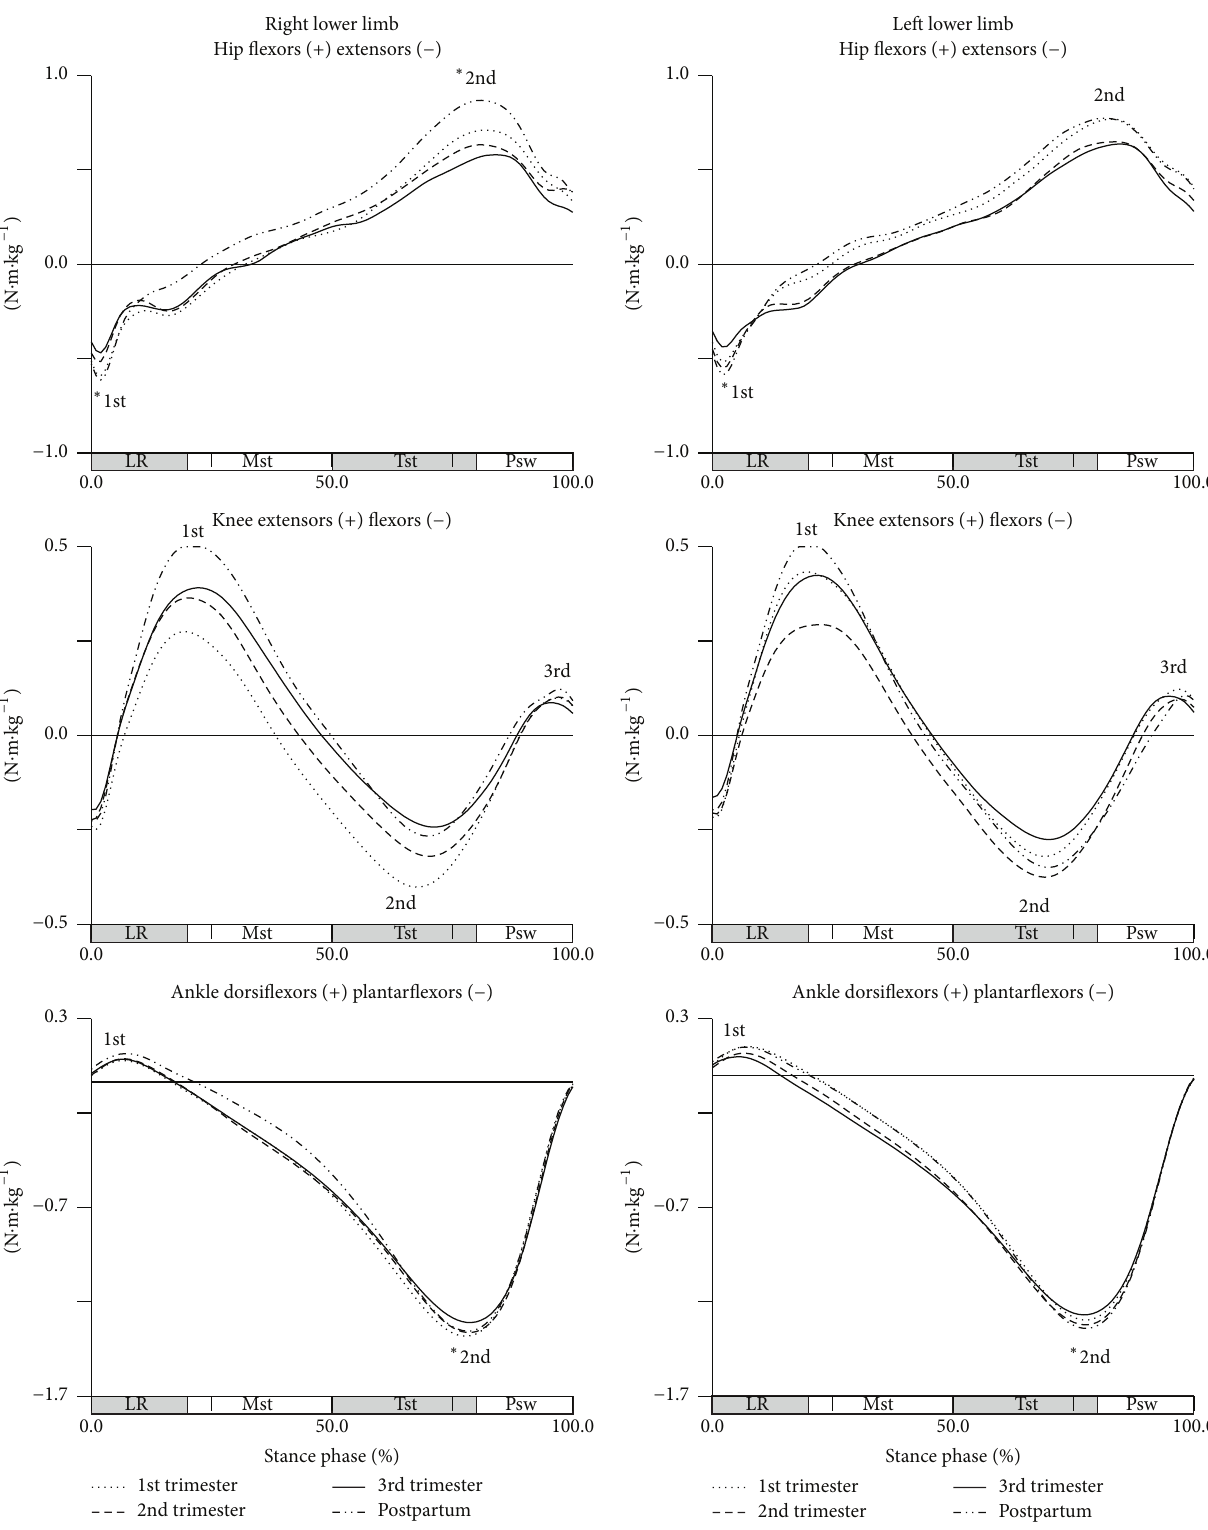
Figure 2: Joints moments in the sagittal plane during gait (in N ⋅ m ⋅ kg −1 ). Each line represents the later stages of first (dotted line), second (dashed line), and third trimesters (solid line) and of postpartum period (dash-dot-dot line). Mean joint moments of the hip, knee, and ankle, for right and left lower limbs. The curve peaks are indicated by numbers: 1st, 2nd, and 3rd, and ( ∗ ) points the significant